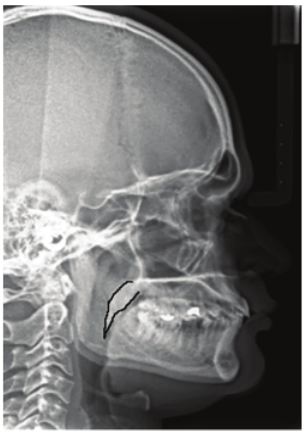
Figure 1: Lateral cephalogram with type 1 (leaf shaped) pattern of soft